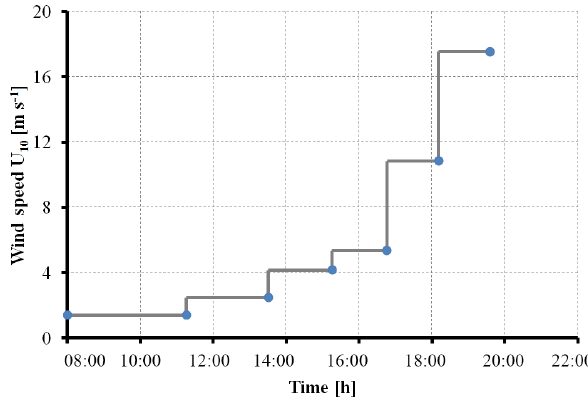
Figure 1. Schematic wind speed ( U 10 ) increase as applied during strategy I for experiments conducted in the